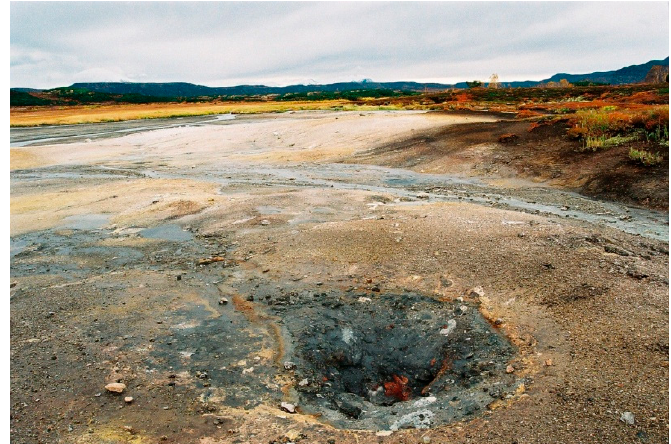
Figure A1. Shaman conduit view in 2010 (photo by G. Karpov, south view).